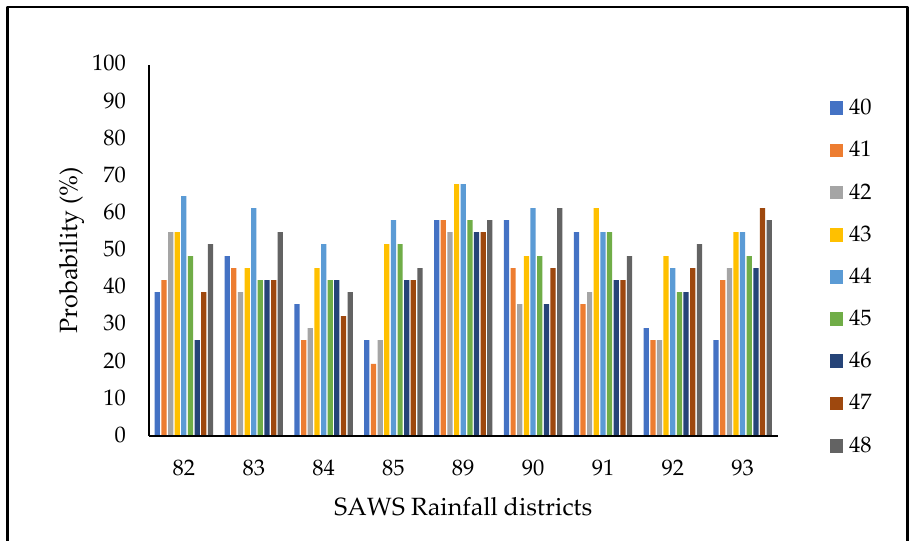
Figure 4. Initial dry ‐ spell probability for selected SAWS rainfall districts from 1985 to 2015 during pentad 40 to 48.